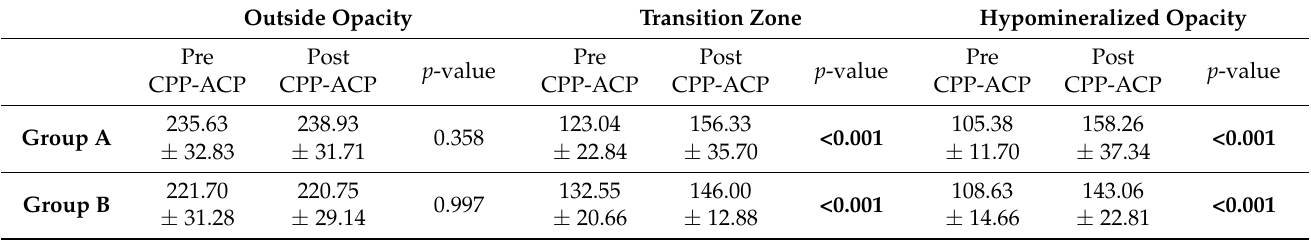
Table 1. Mean microhardness values ± st dev in groups A (white opacities) and B (yellow